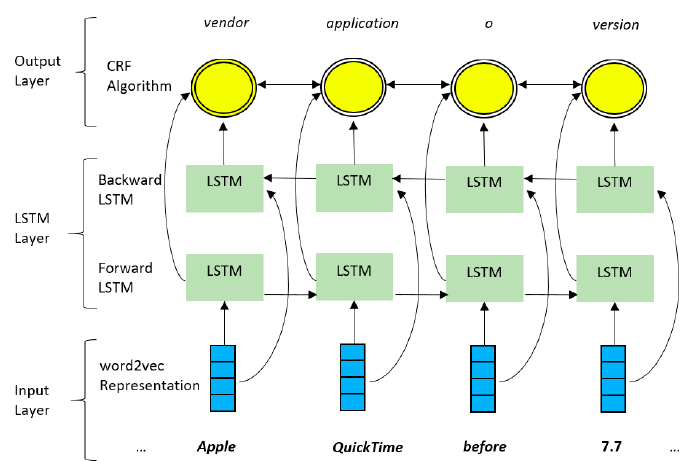
Figure 3. Bidirectional LSTM-conditional random fields (CRF) architecture.